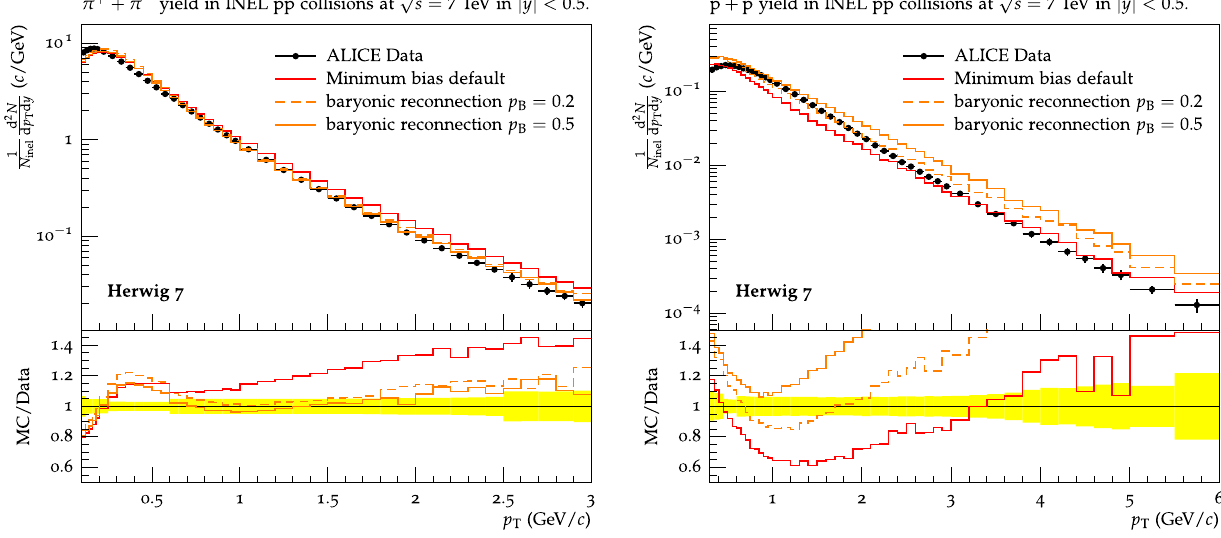
√ s = 7TeV [25] in the very central rapidity